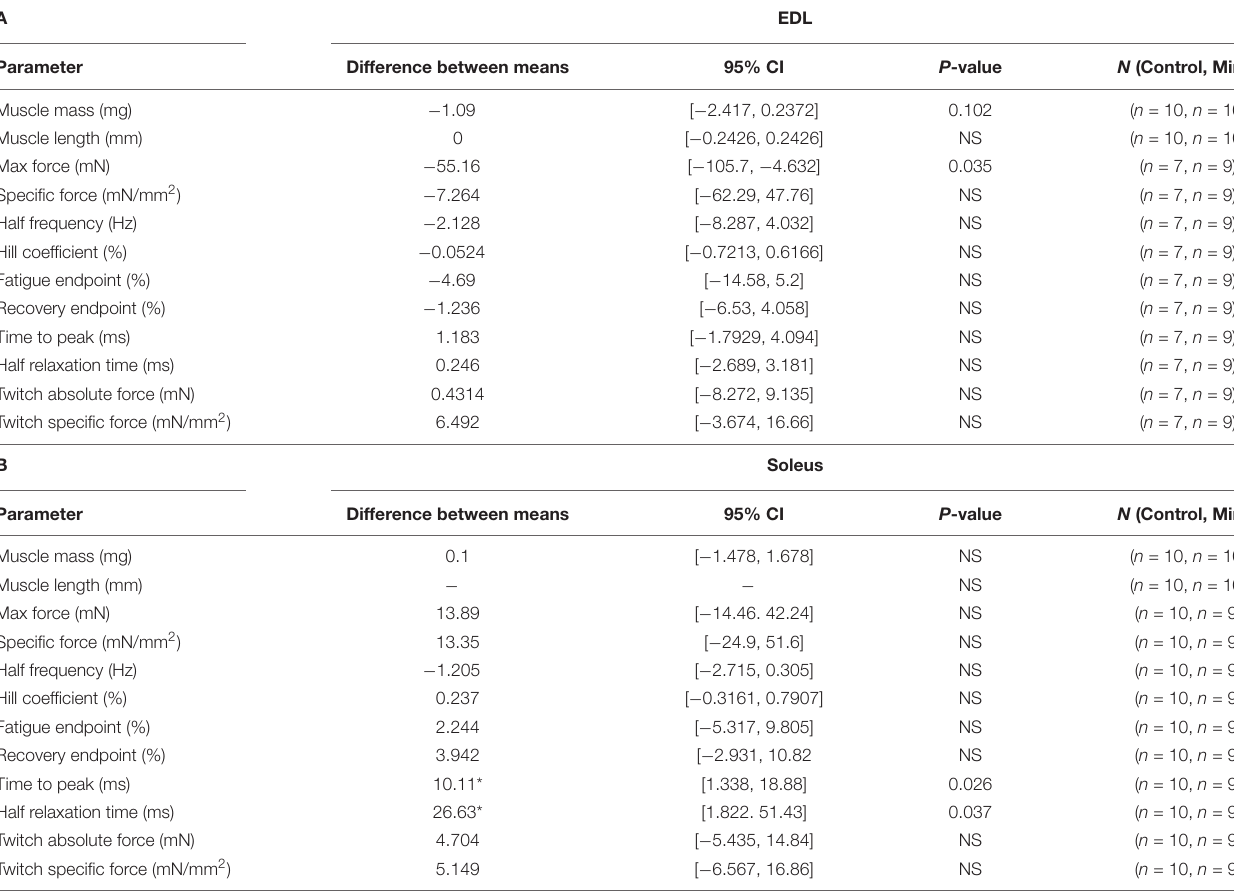
TABLE 3 | Table of descriptive statistical analysis summary for whole muscle parameters measured for A: EDL and B: Soleus.